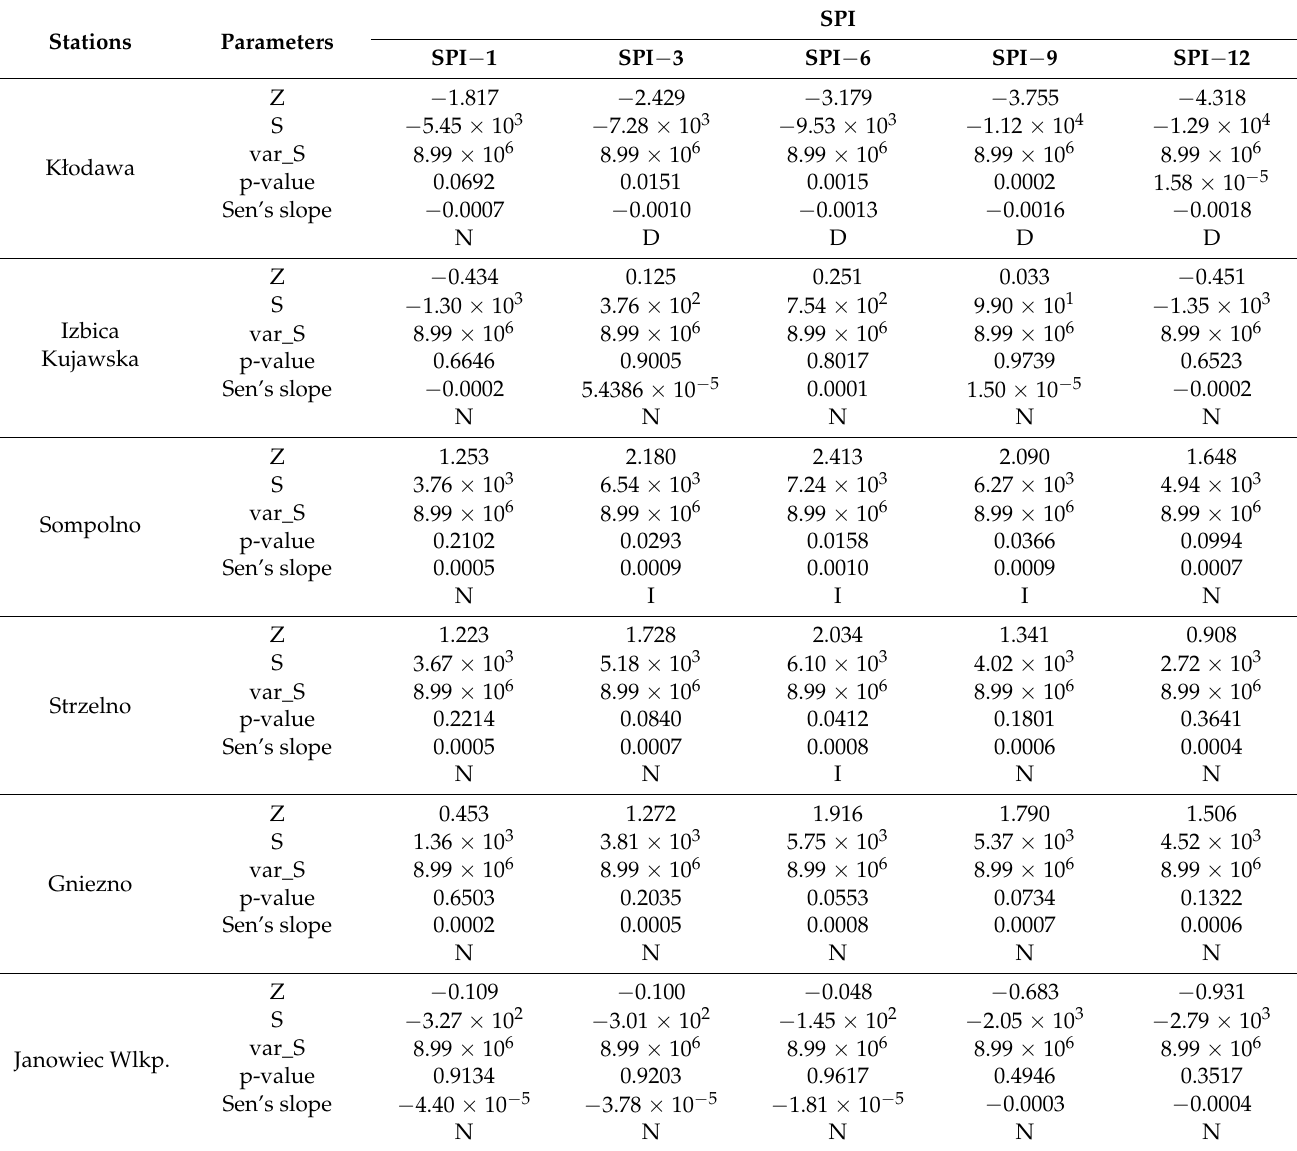
Table 6. Results of trend analysis SPI in different time scales in the period of 1981–2016 at meteorological stations.